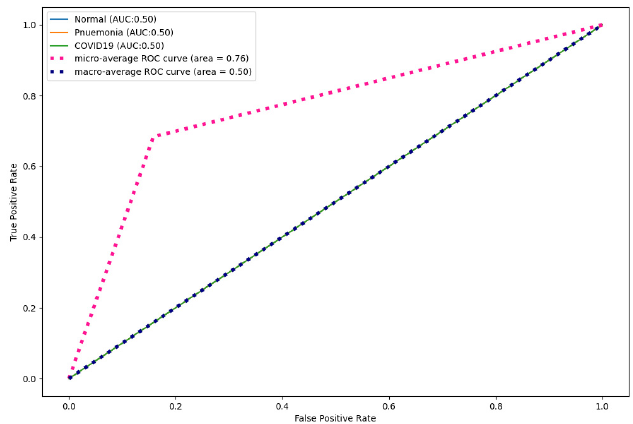
Figure 19. ResNet50 ROC curves for X-ray images.